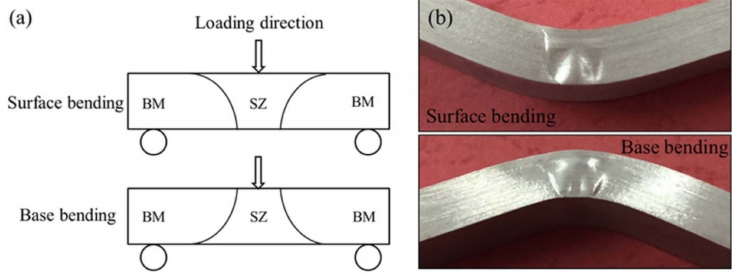
Figure 2. Schematic illustration of three-point bending test ( a ) and macrographs of the ND-TD section ( b ) for friction stir welded (FSWed) Mg alloy